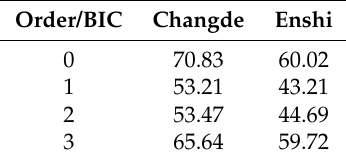
Table 2. BIC criterion for different orders of Markov model for the rainfall occurrences in May